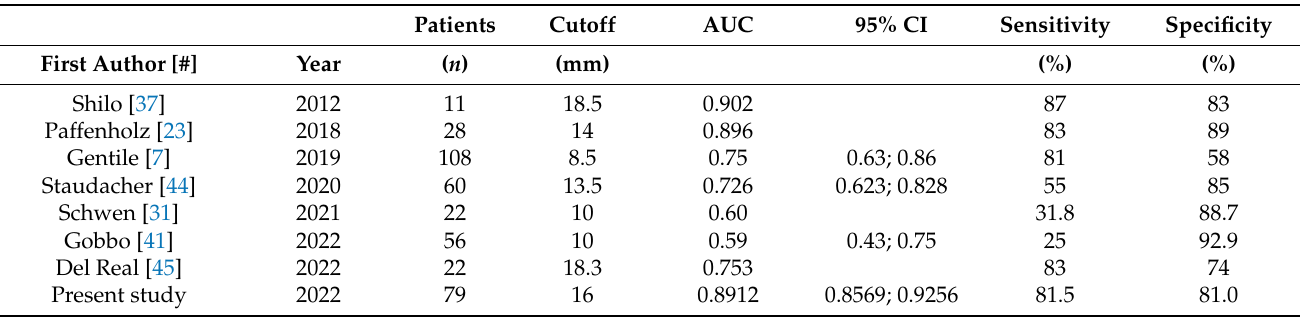
Table 16. Sensitivity and specificity of tumour size as diagnostic tools for assessing small testicular masses—Synopsis of studies using ROC